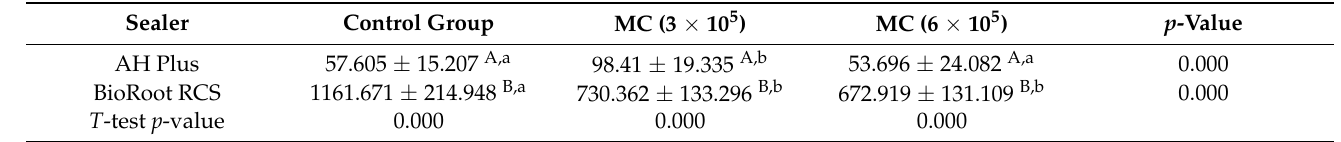
Table 2. Mean and SD of force required for fracture of tooth of tested sealers at two different thermomechanical time periods. Within same row, different superscript lowercase letters mean statistical difference between groups ( p < 0.05). Within same column, different superscript uppercase letters mean statistical difference between groups ( p < 0.05).